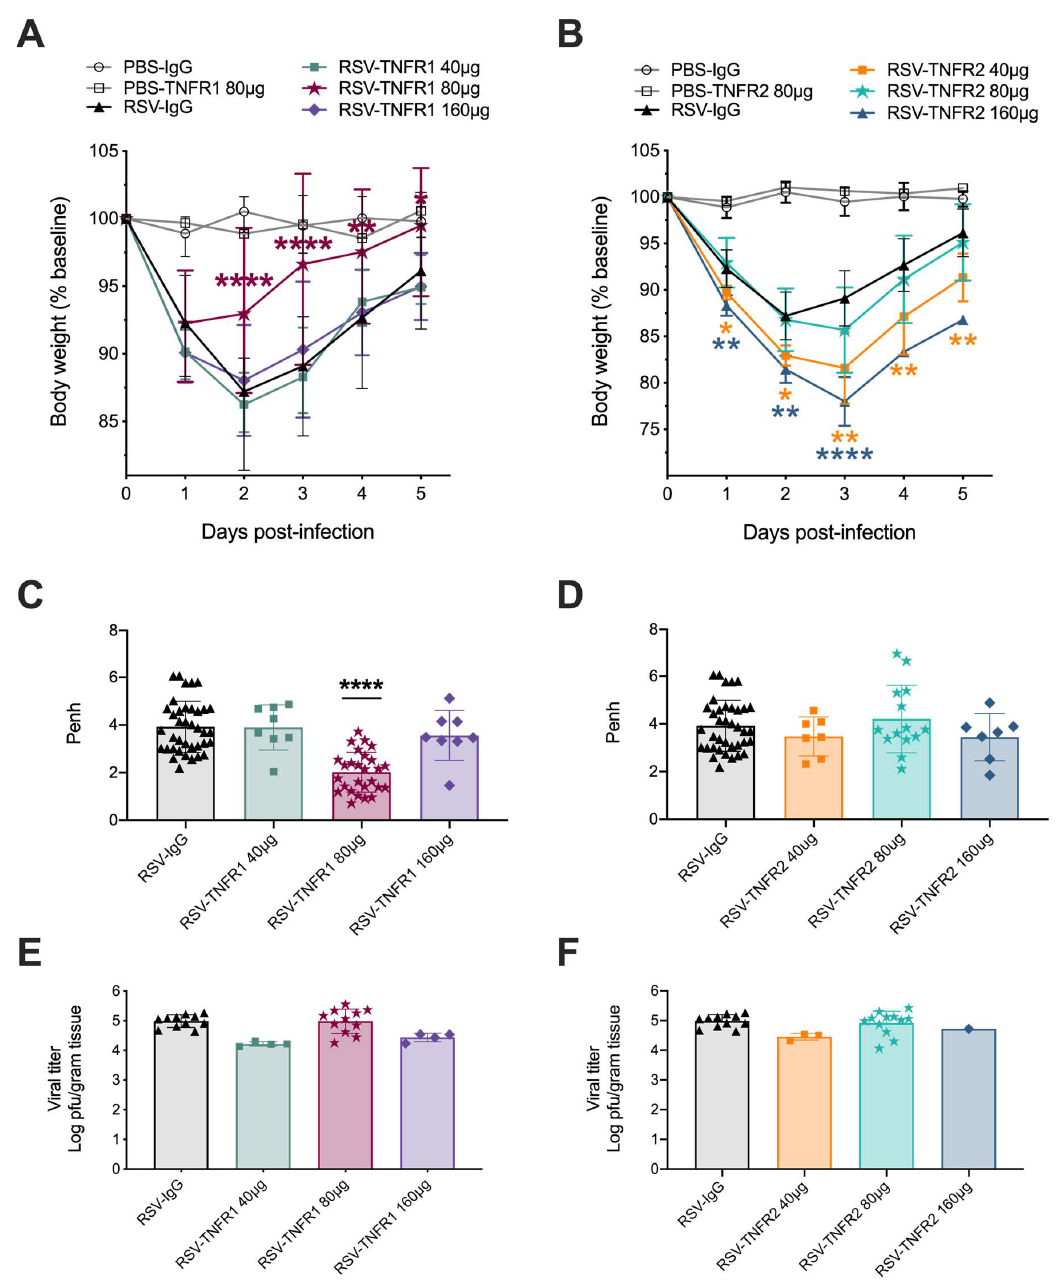
Figure 2. Blockade of TNFR1, but not TNFR2, improves clinical disease and bronchoconstriction in respiratory syncytial virus (RSV)-infected mice. Mice treated with varying doses of ( A ) anti-TNFR1 or ( B ) anti-TNFR2 were monitored over the five-day infection period for changes in body weight. At day one p.i., airway function, represented by baseline Penh, was assessed by plethysmography (Buxco Electronics Inc., Sharon, CT, USA) in ( C ) anti-TNFR1 or ( D ) anti-TNFR2 unrestrained mice. Lung tissue collected at day five p.i. from ( E ) anti-TNFR1 or ( F ) anti-TNFR2 mice was tested for viral titer by a viral plaque assay. Data for 40 µ g and 160 µ g anti-TNFR1 / TNFR2 are representative of one-independent experiment. Data are pooled from four independent experiments for 80 µ g anti-TNFR1 and from three independent experiments for 80 µ g anti-TNFR2. All data are expressed as mean ± SD. Significant results as compared to the control RSV-IgG mice are marked with asterisks (* p ≤ 0.05, ** p ≤ 0.01, **** p ≤